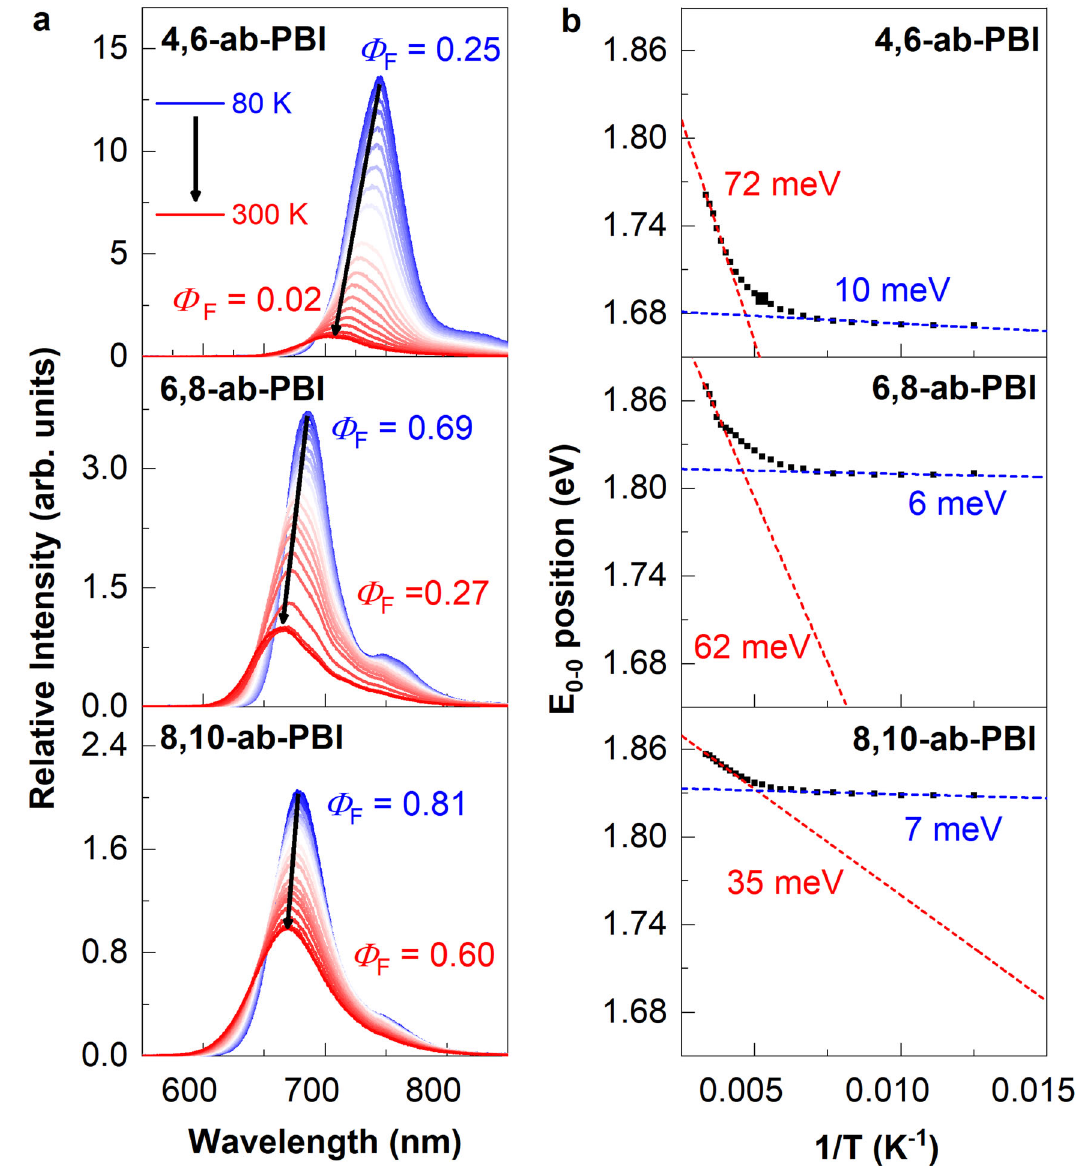
Fig. 5 | Temperature-dependent steady-state fl uorescence spectra of PBIs crystalline fi lms. a Temperature-dependent steady-state fl uorescence spectra of PBIs crystalline fi lms (heating from 80K to 300K, λ ex =480nm). b